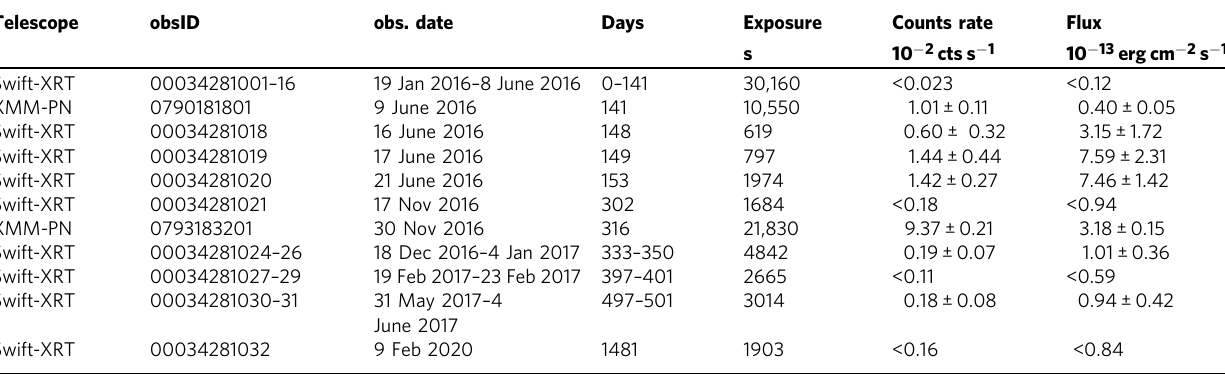
For non-detections in either individual epochs or combined data, the corresponding 3 σ upper limits on the counts rate and fl ux are given. The X-ray counts rate and fl ux is in the 0.3 – 2keV, respectively. The X-ray fl ux is corrected for the internal and Galactic gas